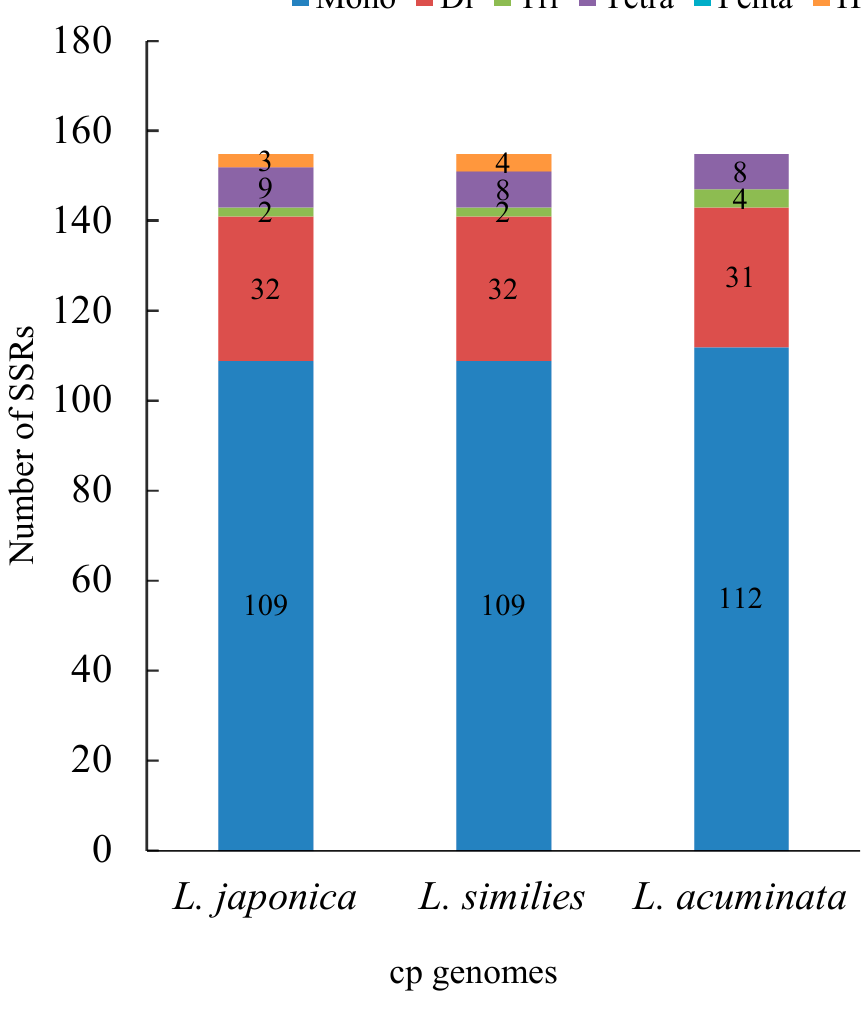
Figure 3. SSR analysis of three cp genomes. The ordinate represents the number of SSRs; the abscissa represents three cp genomes.